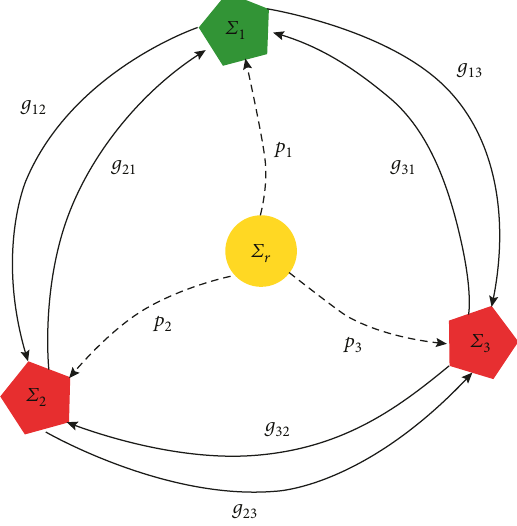
Figure 2: Example of a connection graph; the green pentagon, red pentagons, and yellow circle, respectively, indicate an active β -cell, the inactive β -cells, and the reference β